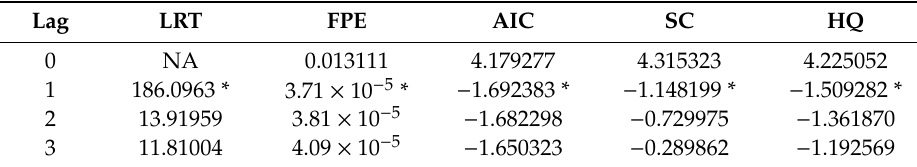
Table 4. Optimal lag criteria.